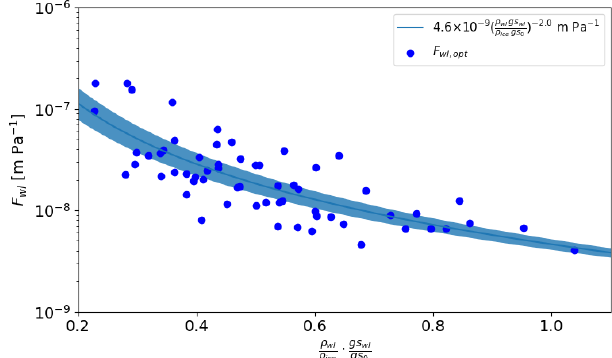
Figure 6. Modeled r c values (Eq. 2) with layer properties from SNOWPACK (blue dots) and from manual profiles (orange dots) with averaged measured critical crack lengths from PST exper- iments. Error bars indicate the range of measured critical crack lengths for each point. The black line is the 1 : 1 line.